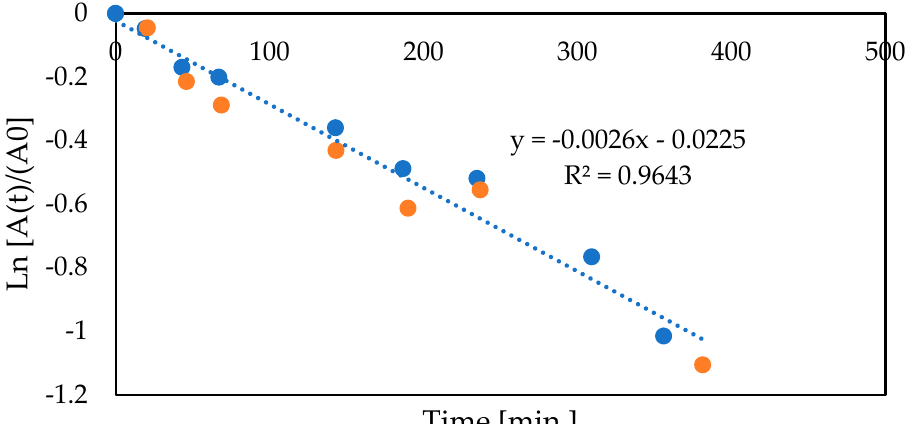
Time [min.] Figure 4. Half-life time of co-encapsulated glucose oxidase and catalase (blue points GOX 1.38 g/L, CAT 0.22 g/L, orange points GOX 2.76 g/L, CAT 0.45 g/L, glucose 27.5 g/L, capsules volume 3 mL, total volume 18 mL, 0.1 M HEPES buffer pH 6.6, 12 °C, CaCO 3 4 g/L, compressed air 3 L/h).